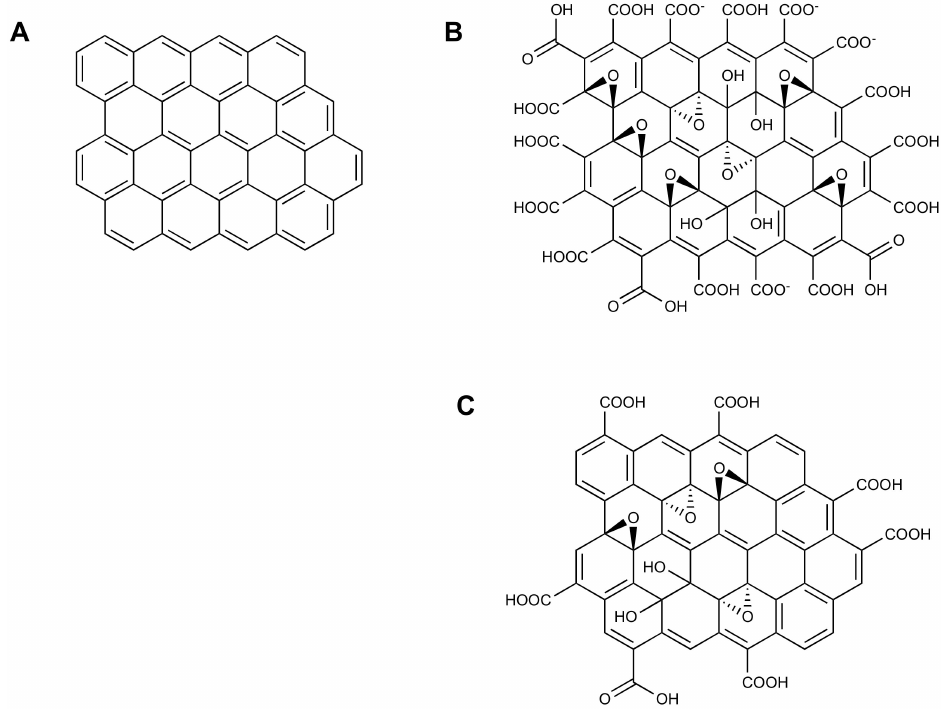
Figure 1. Structure of ( A ) graphene, ( B ) graphene oxide, and ( C ) reduced graphene oxide. Reproduced with permission [6]. Copyright 2018,